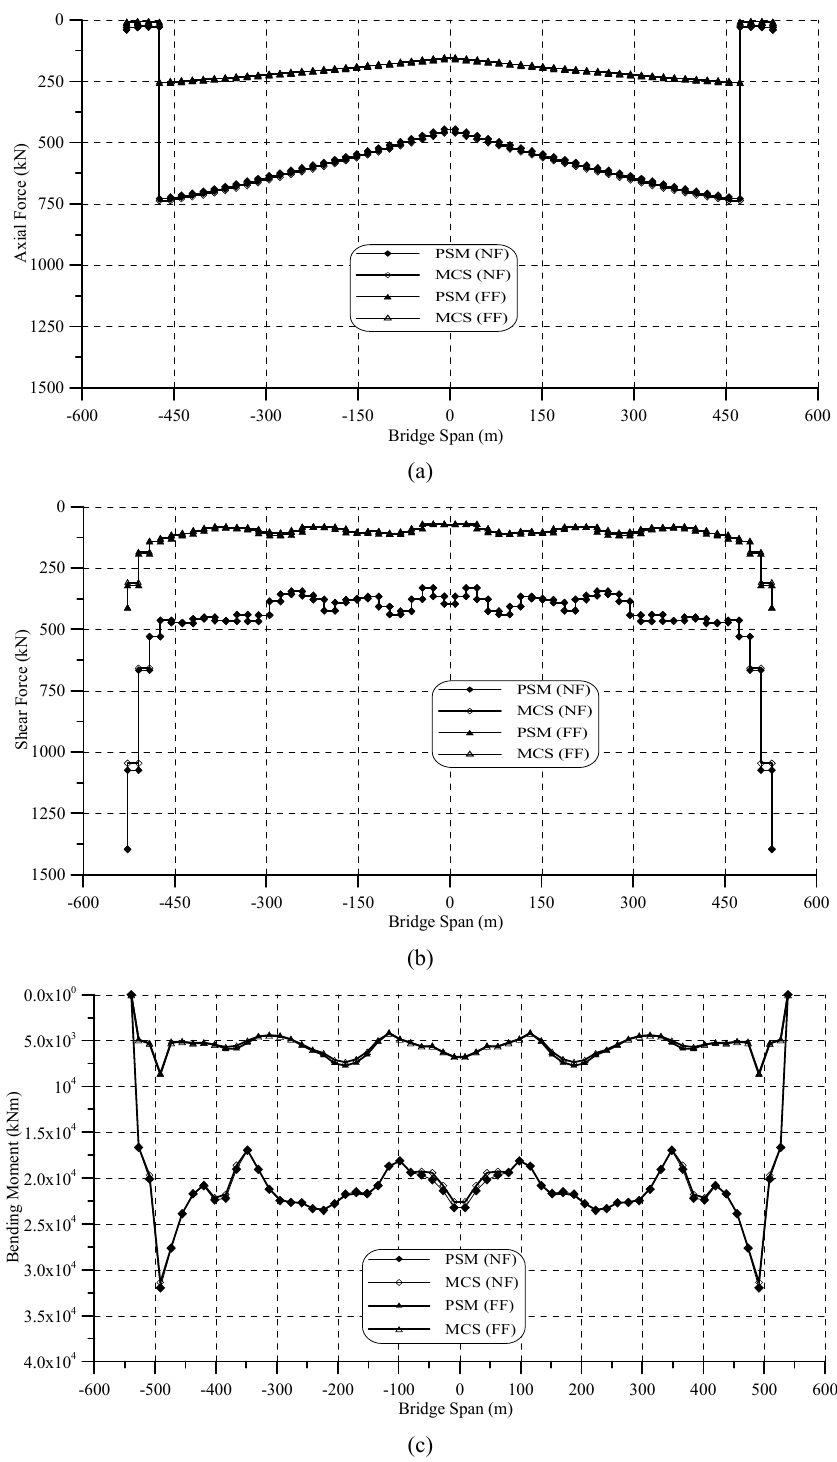
Fig.13. Maximum sensitivity axial forces (a), shear forces (b) and bending moment (c) for deck of Fig. 13. Maximum sensitivity axial forces (a) , shear forces (b) and bending moment (c) for deck of Fatih Sultan Mehmet Bridge for random Fatih Sultan Mehmet Bridge for random elastic module (E) elastic module